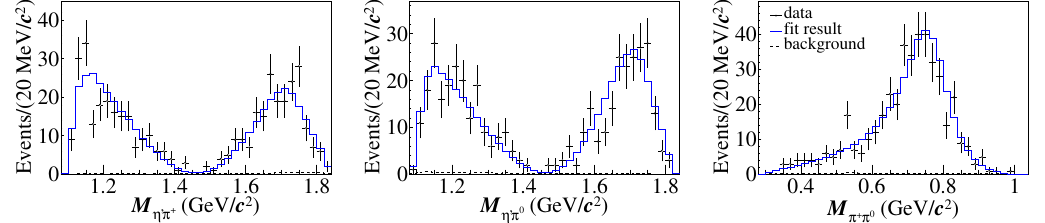
Figure 4 . The Dalitz plots of m 2 samples generated based on the results of the amplitude analysis at physical border is indicated by the black line.